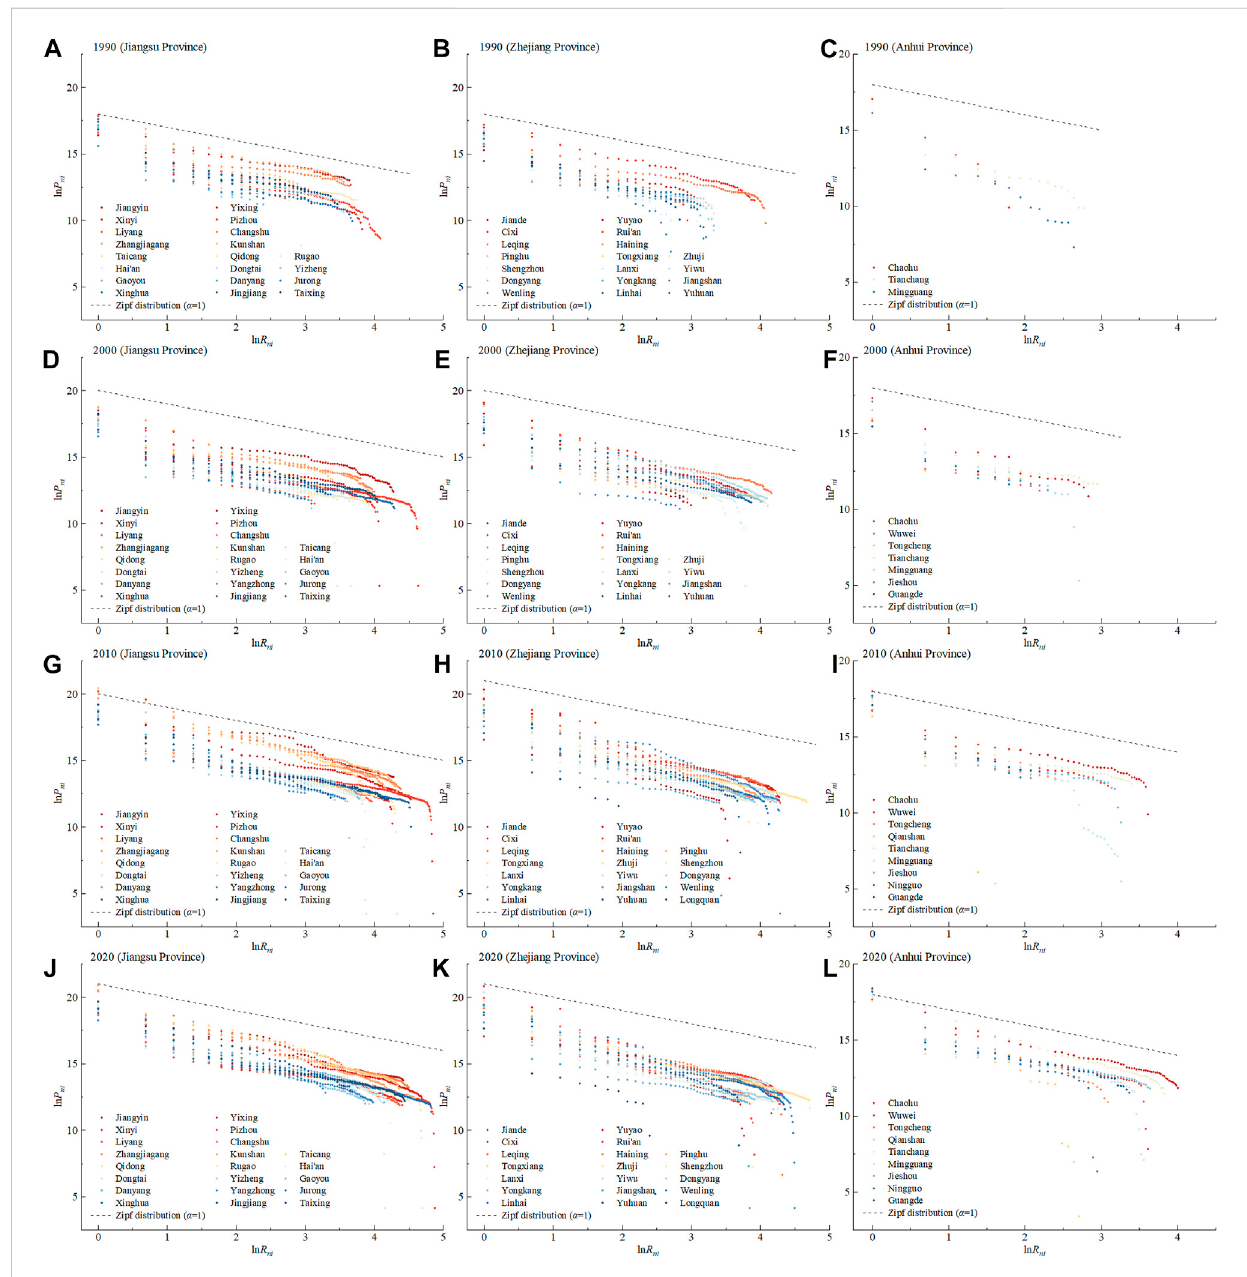
FIGURE 5 Intra city-size distribution of YRDR (county-level